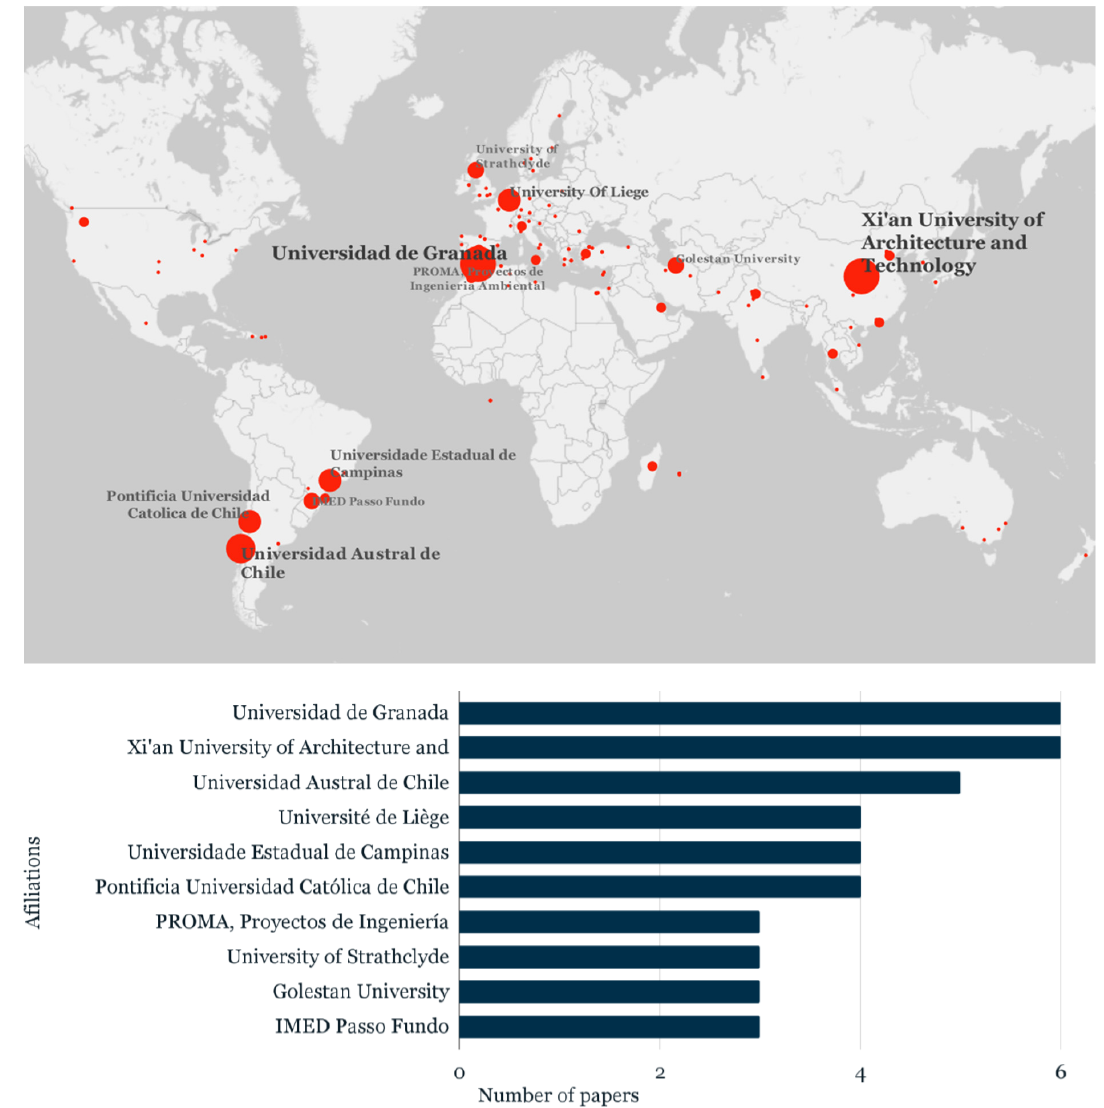
Figure 13. A map of affiliations or public organizations which publish more articles than others in CZB.